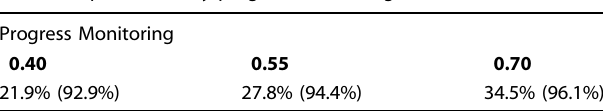
Table 2. Positive and negative predictive values of progress monitoring tools as a screener for learning disabilities (tenth percentile or lower